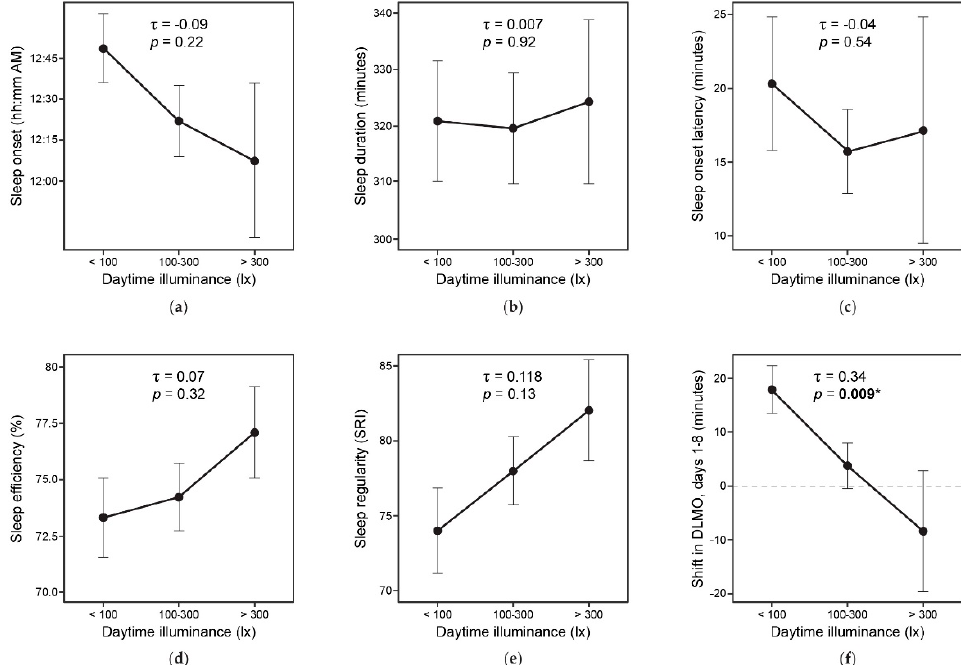
Figure 9. Kendall’s Rank Correlation showing the relationship between mean daytime illuminance measured in participants’ apartments and the study outcomes: ( a ) sleep onset, ( b ) sleep duration, ( c ) sleep onset latency, ( d ) sleep efficiency, ( e ) sleep regularity, and ( f ) shift in DLMO. (Abbrevia- tions: SRI, Sleep Regularity Index; DLMO, dim light melatonin onset; statistical significance: * rep- resents p ≤ 0.05).